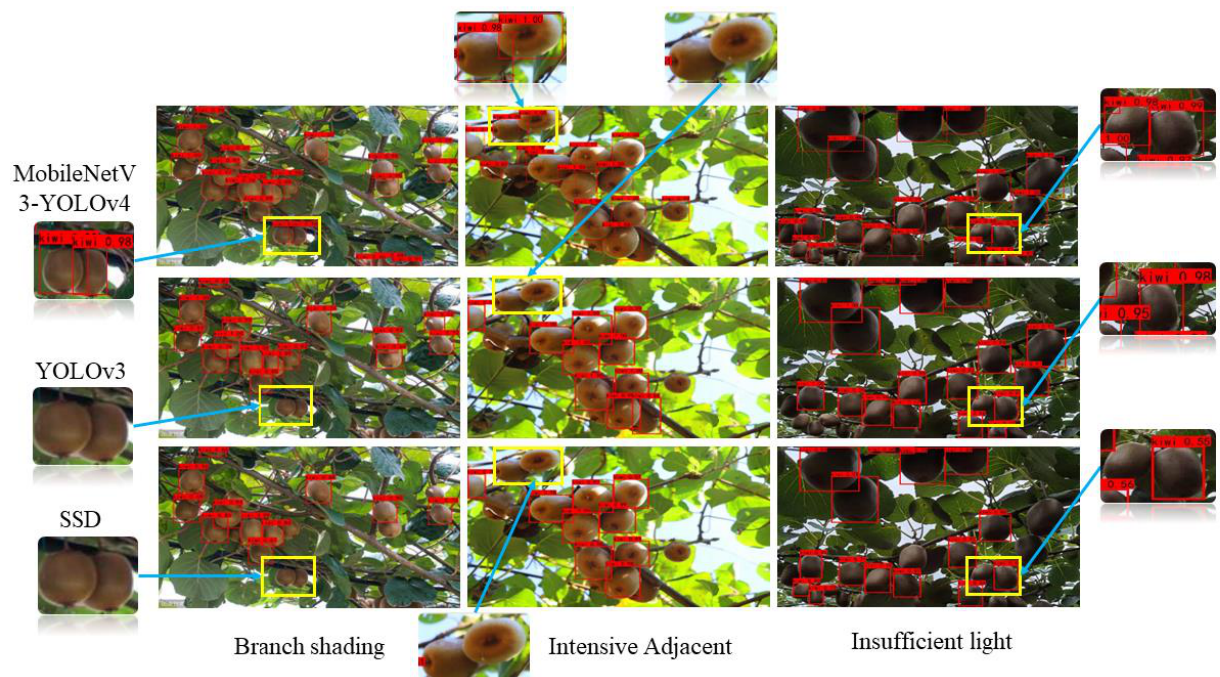
13 of 15 Table 4. Performances of different algorithms. Network Model